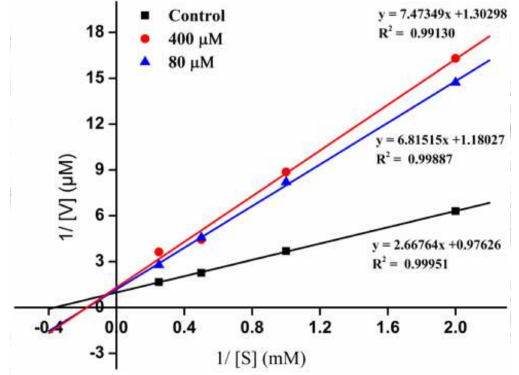
Figure 4. Line weaver-Burk plot of ACE inhibition by